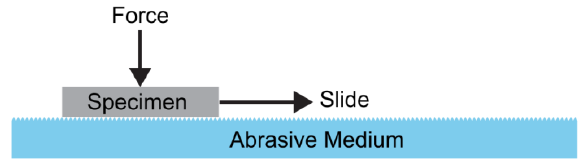
Figure 13. Schematic diagram of a simple abrasion test for superhydrophobic materials.